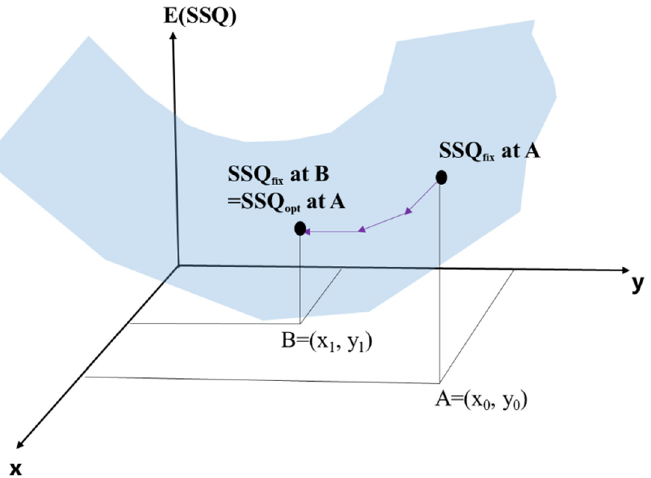
Figure 2. Schematic explaining the concepts of SSQ fix and SSQ opt . SSQ fix is the error value resulting from the given inputs (x 0 , y 0 ), whereas SSQ opt is the error at the final point of convergence.